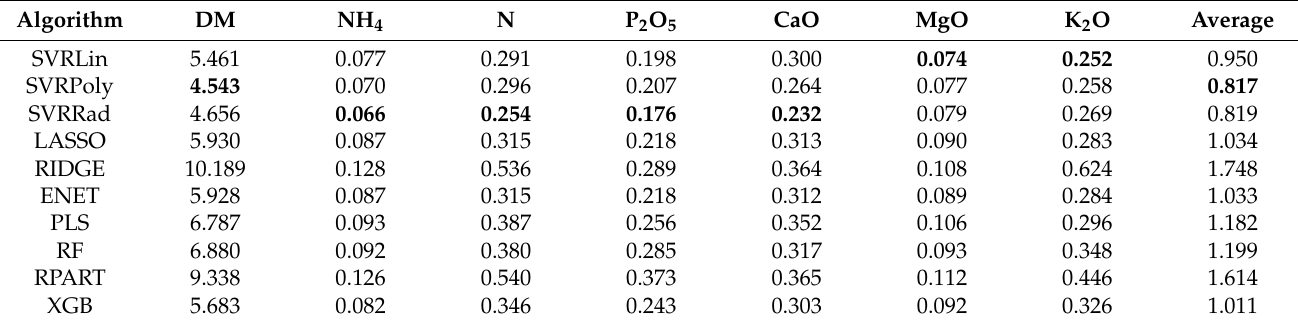
Table 4. Comparison of the root mean square error of cross validation ( RMSECV ) (% wet weight) among the seven chemical components (i.e., dry matter (DM), total ammonium nitrogen (NH 4 ), total nitrogen (N), P 2 O 5 , CaO, MgO, and K 2 O) of the fresh homogenized samples using various machine learning techniques (SVRLin = support vector regression with linear kernel; SVRPoly = support vector regression with polynomial kernel; SVRRad = support vector regression with radial kernel; LASSO = least absolute shrinkage and selection operator; RIDGE = ridge regression; ENET = elastic net regression; PLS = partial least squares; RF = random forests; RPART = recursive partitioning and regression trees; XGB = boosted trees). Best results are indicated in